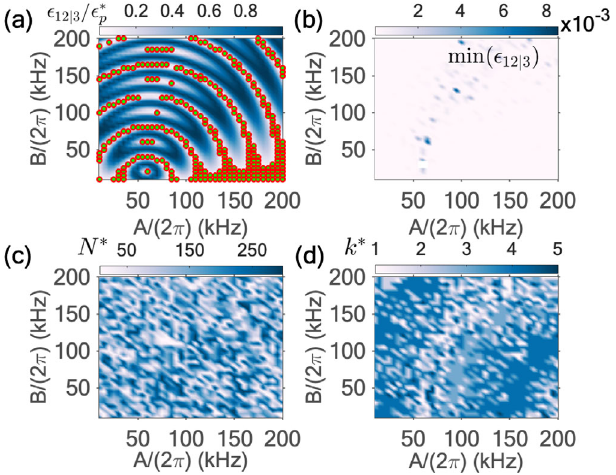
FIG. 12. Controlling a target spin with parameters ð A; B; ω 2 π · ð 60 ; 30 ; 314 Þ kHz in the presence of an unwanted spin with varying HF parameters ∈ 2 π · ½ 10 ; 200 (cid:2) kHz. (a) One-tangle of the unwanted spin, scaled by the maximum bound of ϵ (cid:3) The time of the unit is the first resonance time of the target spin, and the number of iterations is N ¼ 20 , which maximize its one- tangle. (b) Minimization of the one-tangle of the unwanted spin using the first five ( k ¼ 1 ; … ; 5 ) resonances of the target spin and up to 300 pulses on the electron. Optimal number of repetitions (c) and optimal resonance (d) to minimize the unwanted spin ’ s one-tangle while keeping the one-tangle of the target spin maximal. In all plots, we consider the CPMG sequence and an electron spin S ¼ 1 ( s 0 ¼ 0 and s 1 ¼ − 1 ).